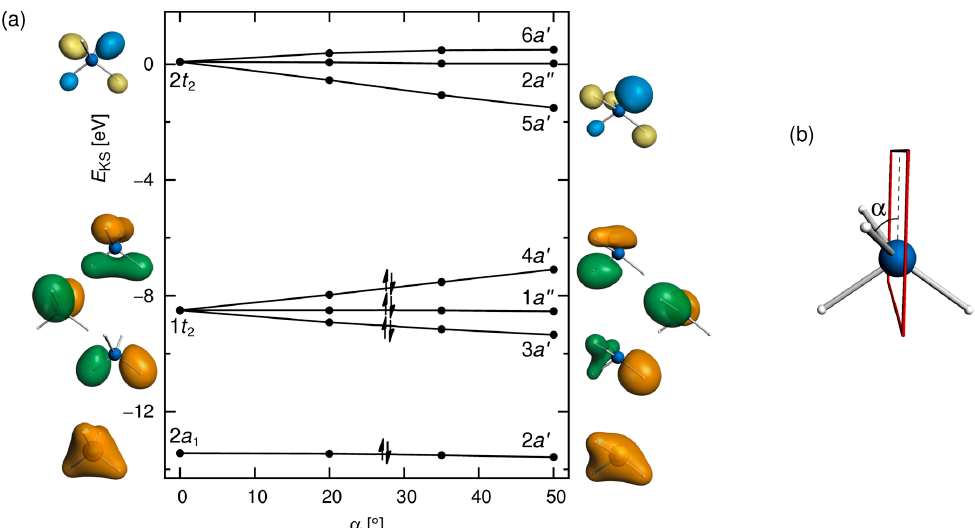
Figure 2. ( a ) Walsh diagram of the silane molecule: Kohn-Sham energies (calculated at PBE-D3/TZ2P) of selected valence orbitals as a function of the tilting angle α , i.e., the deflection of two Si–H bonds from the ideal tetrahedral arrangement. At α = 0°, only the 2 t 2 orbital that transforms into the LUMO of the distorted molecule (5 a ′ ) is shown. ( b ) Definition of α . Still, this does not explain the activation of the Si down –Si sub bonds, since the HOMO (4 a ′ ), while raised in energy, is located at three Si–H bonds. However, on Si(001) the structure is even further reduced in symmetry and the two distorted bonds are not tilted by the same amount. This is because every Si sub atom is connected to one Si down and one Si up in the minimum configuration (Figure 1b) and the corresponding bonds are tilted by a different α : Approximately 30° (towards Si up ) and 50° (towards Si down ). When this geometry is reproduced in silane, an additional symmetry reduction takes place ( C s to C 1 ), the HOMO (Figure 3a) becomes a mixture of orbitals 4 a ′ and 1 a ′′ of the C s -symmetric